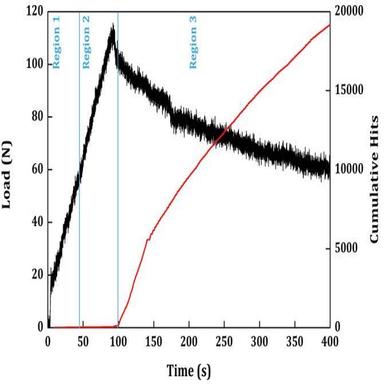
Load vs Time and Cumulative Hits vs Time for Specimen C.